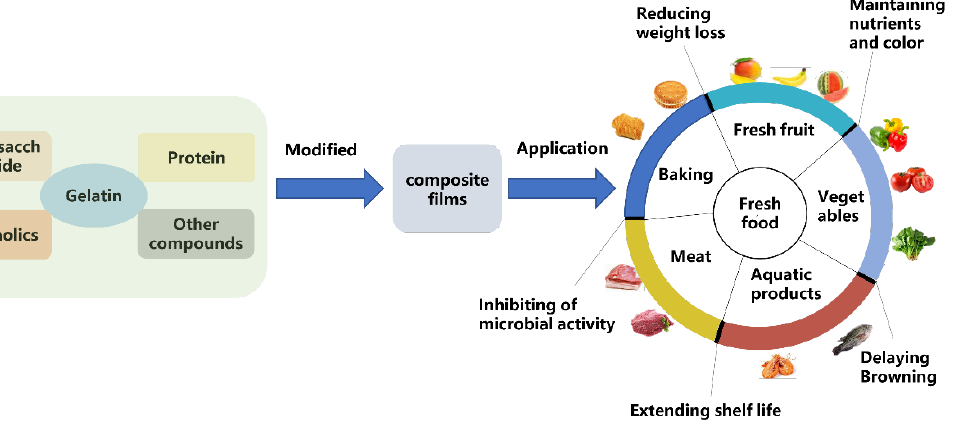
Figure 8. Modification and functional application of gelatin-based edible composite films in food